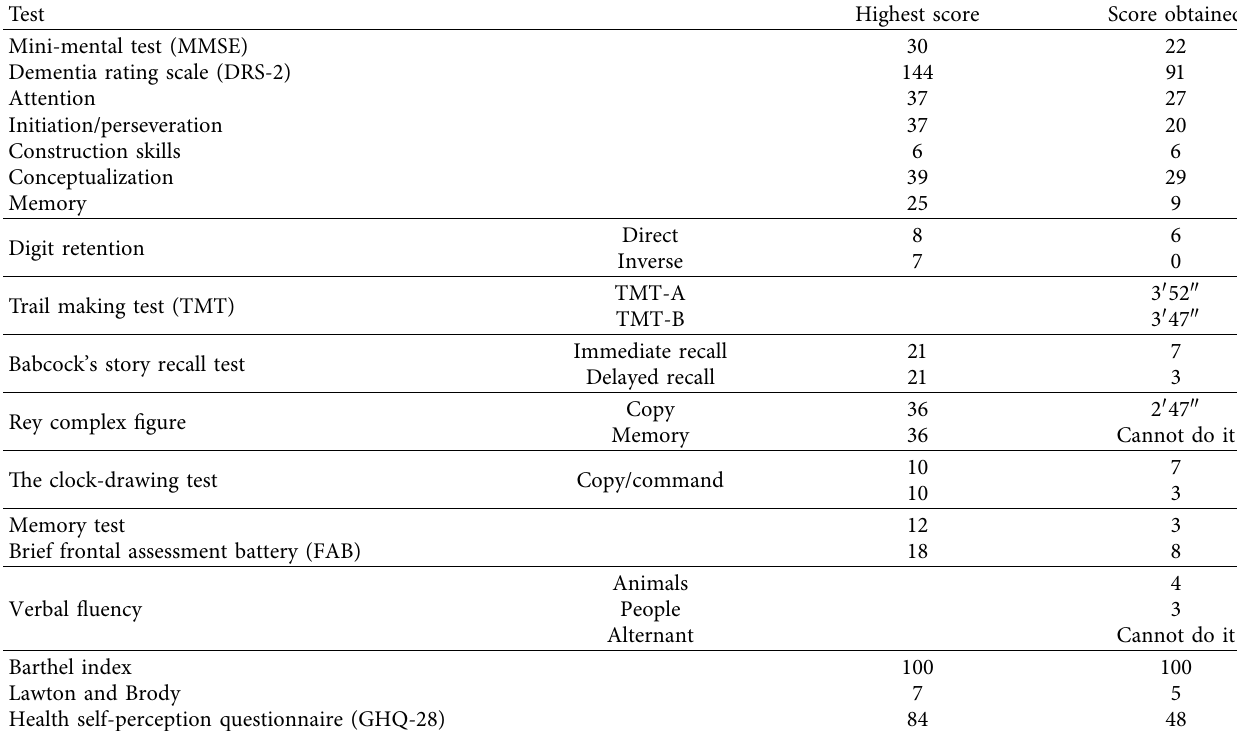
Table 2: Scores obtained in diferent neuropsychological tasks as a function of a patient with Korsakof’s syndrome. Test Highest